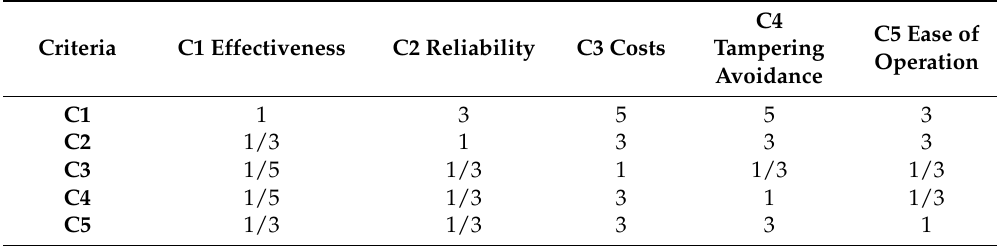
Table 1. Preference matrix A.